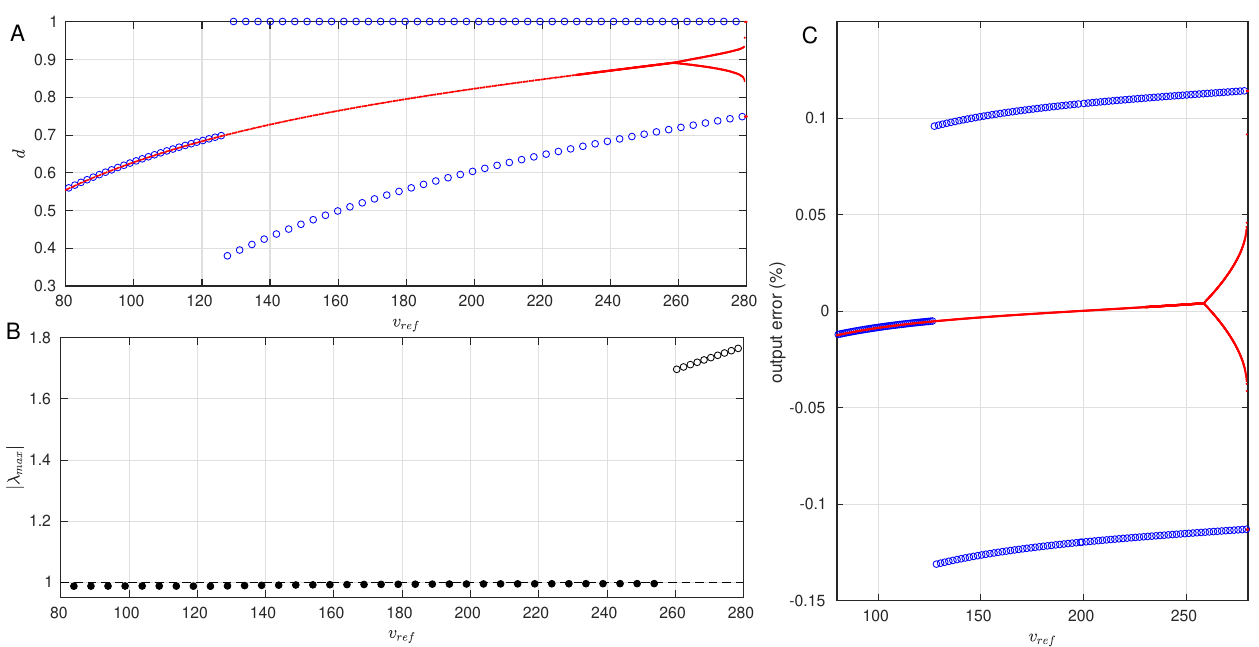
Figure 5. Bifurcations with v ref as a control parameter. ( A ). The duty cycle solution (11) in steady state with two protocols: Red (blue) line corresponds to increasing (decreasing) variations of the parameter. ( B ). Maximum Floquet multiplier of the period-1 orbits found in the studied interval. Solid (empty) symbols refer to stable (unstable) orbits. ( C ). Output error of the attractors of panel A, with the same color code. The parameters of this simulation, as in Table